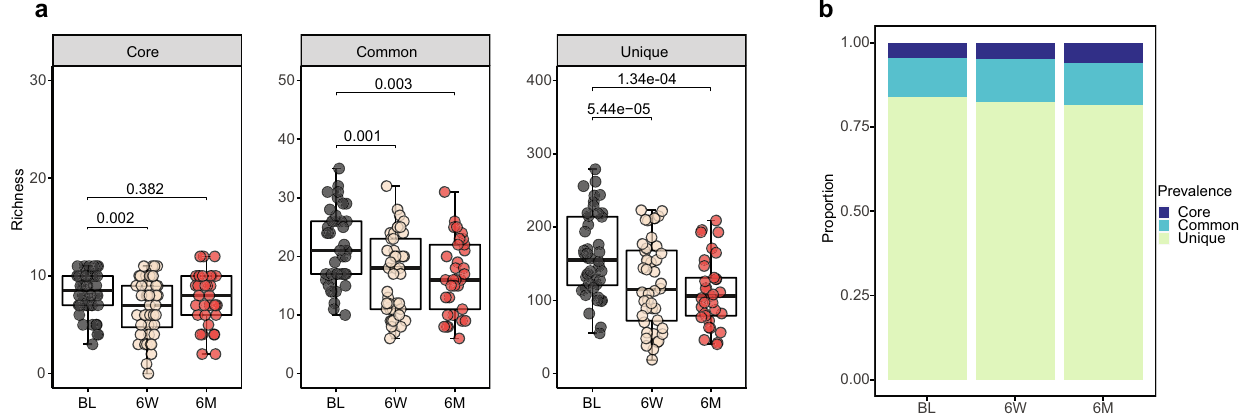
Fig. 1 | Alteration of core, common, and unique viruses after H. pylori eradi- cationtherapy.a Boxplotsshowthecomparisonofrichnessofviralspeciesateach prevalence level (core, common, and unique) among the three groups (two-sided Wilcoxon tests and adjusted by Benjamini – Hochberg (BH) method for multiple comparisons; Baseline, N =44; 6-week, N =44; 6-month, N =33). b Stacked plots